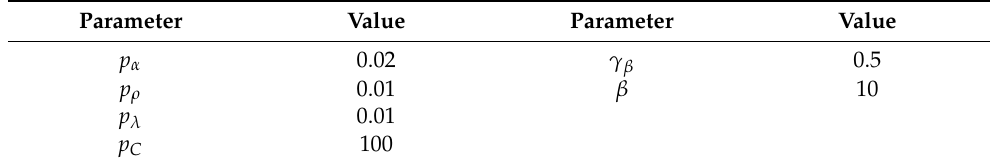
Table 2. Model topological